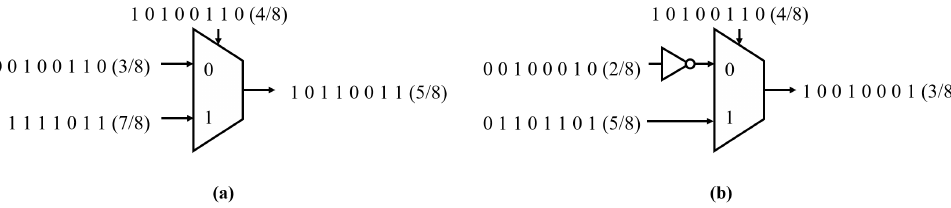
Figure 7. Example of stochastic addition and subtraction: ( a ) Stochastic addition, ( b ) Stochastic